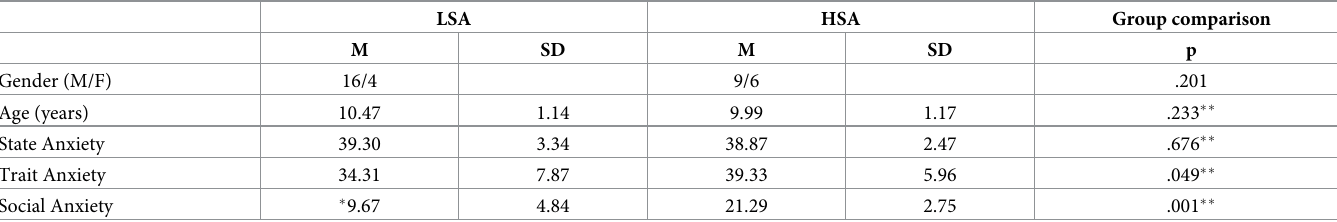
Table 1. Demographic and psychopathological data for the LSA and HSA groups ( �� p-values < .01; � p-values < .05) (M = male; F =